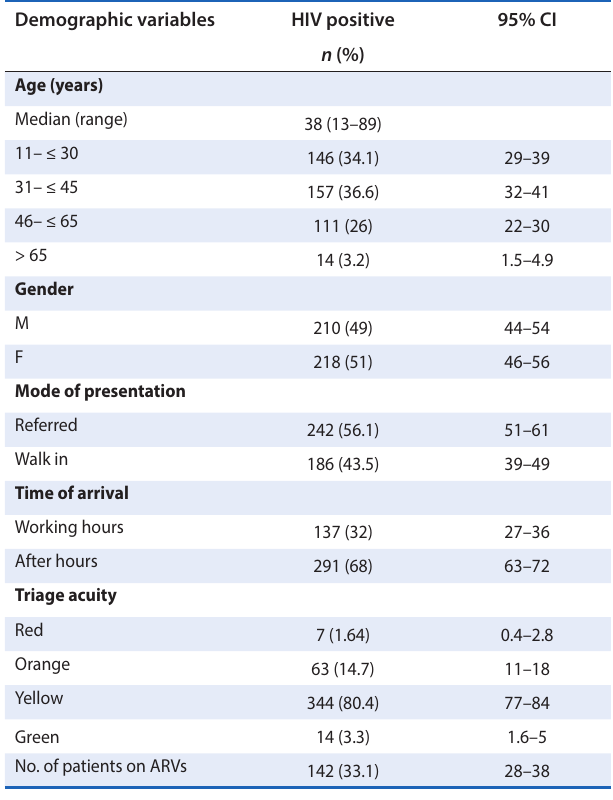
Table 1: Demographic profile of HIV-positive patients